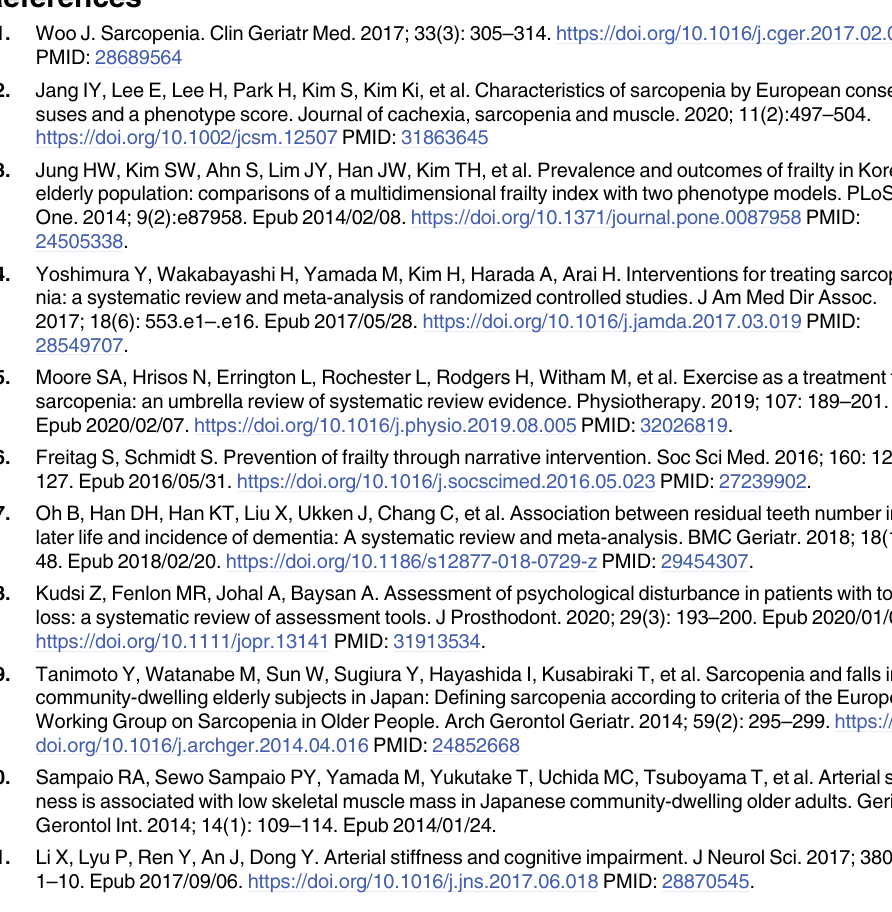
S3 Table. The number of participants who fell below the diagnostic criteria for sarcopenia was divided by sex and sub-category (pre-sarcopenia and